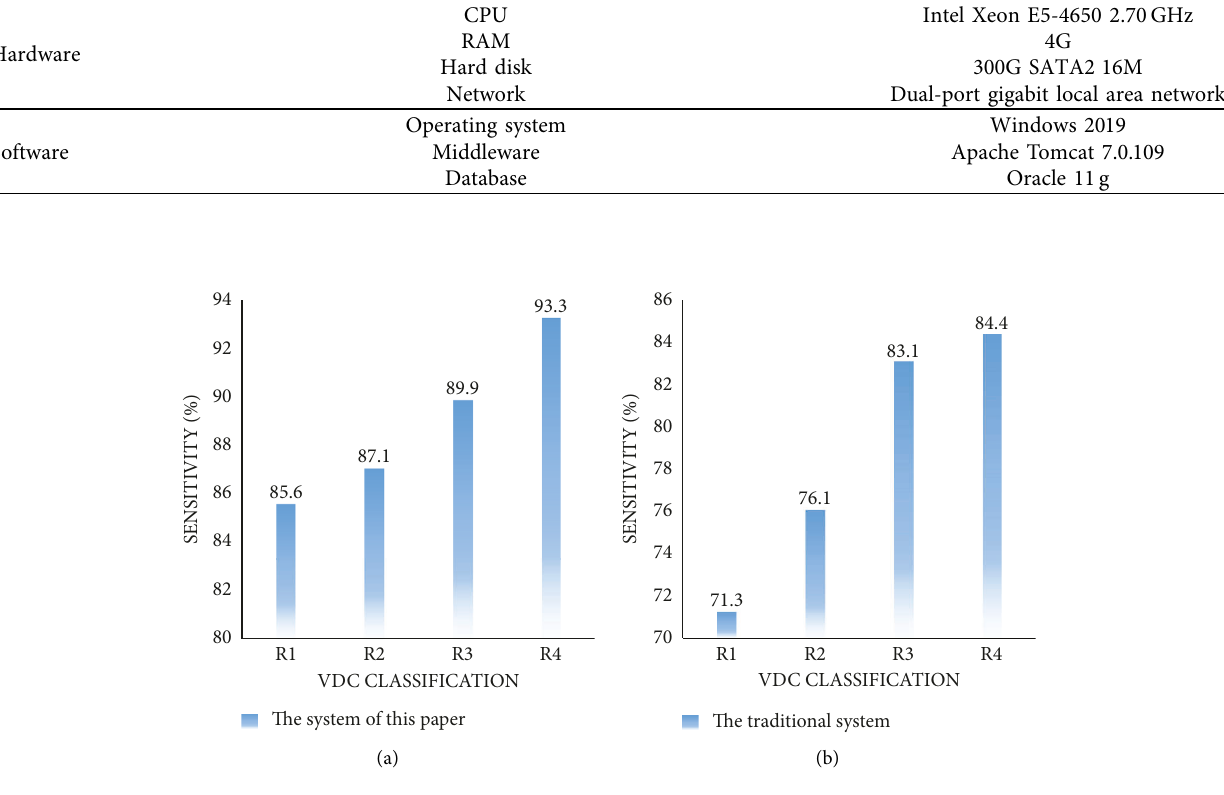
Figure 5: Sensitivity test results. (a) The monitoring system of this study. (b) The traditional monitoring system.